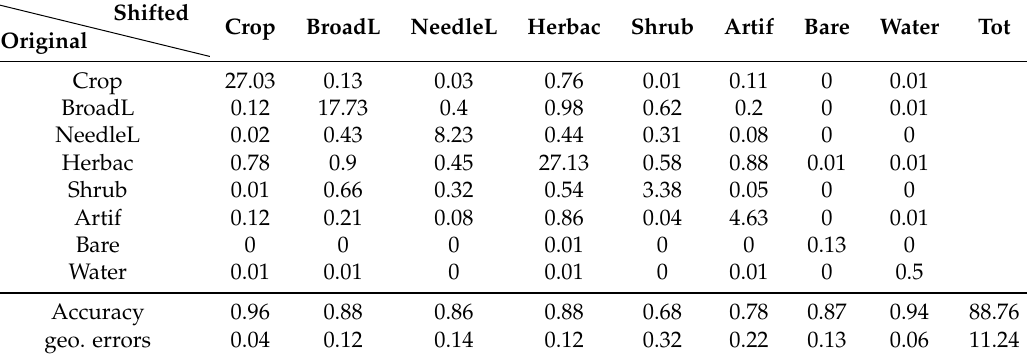
Table 6. Total weighted confusion matrix for a maximum shift of 1.5